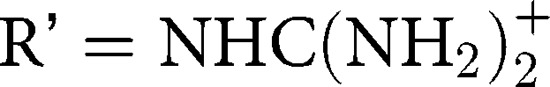
Docking of ligand 5 with various substitutions in N1 neuraminidases (sources: pdb 2HU0 and 2HU4).(A) Docking of 5A
R’=NHC(NH2)2+ R = CH(CH2CH3)2); (B) Docking of 5B (R’=NHC(NH2)2+ and R = CH2CH3); (C) Docking of 5C
R’=NHC(NH2)2+ and R = CH2CH(OH)(CH2OH).